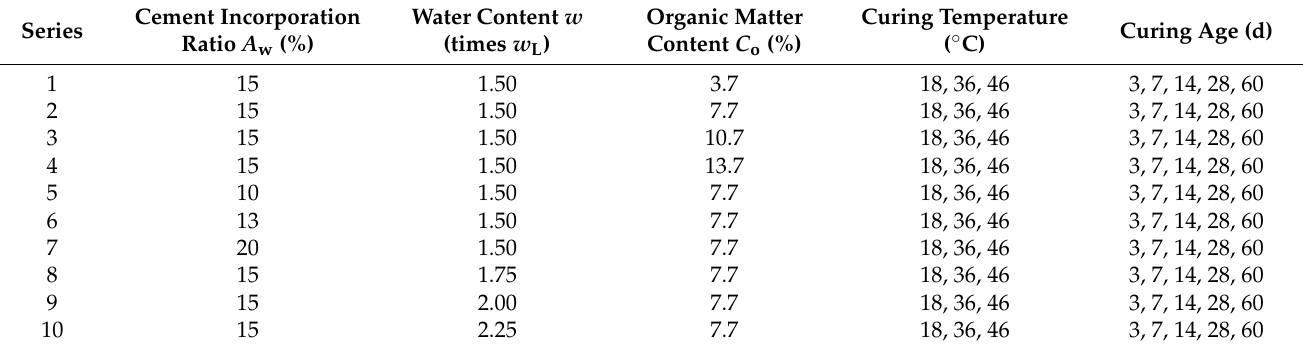
Table 3. Test scheme used in this